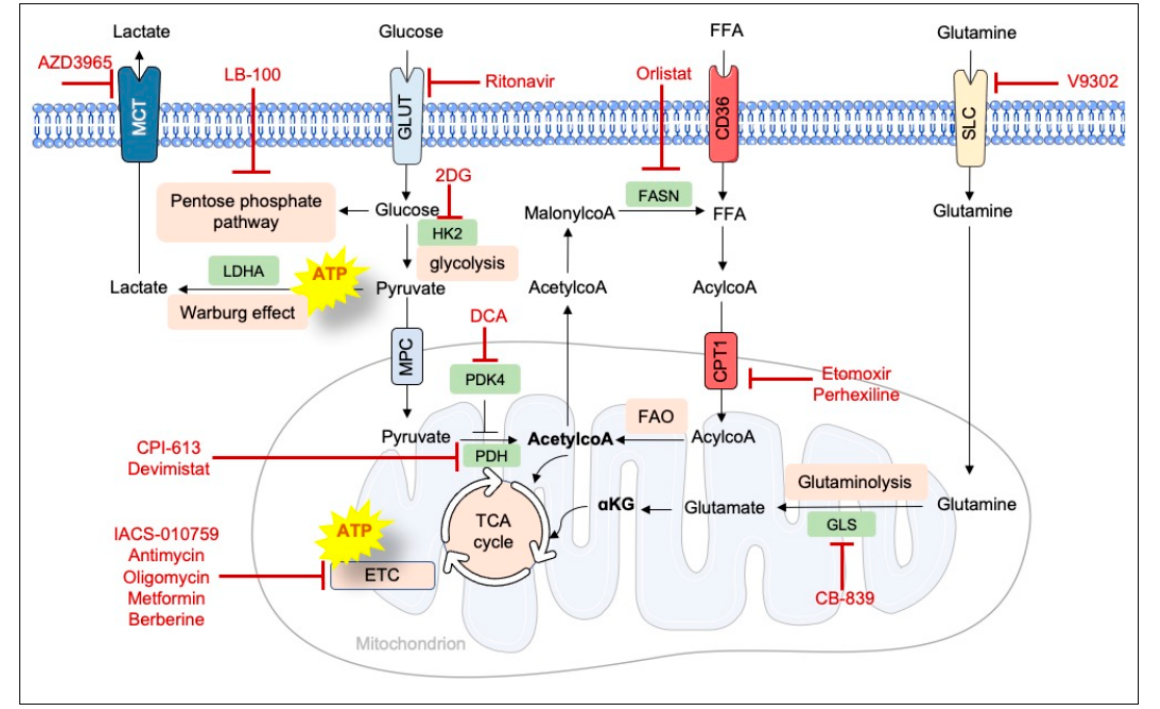
Figure 3. The cell’s main metabolic pathways and the corresponding inhibitors. Glucose, free fatty acids (FFAs) and glutamine enter cells via glucose transporters (GLUT), CD36, and solute carrier (SLC) transporters respectively. Once inside the cells, these substrates are catabolized by various metabolic reactions in the cytosol and the mitochondria in the tricarboxylic acid cycle (TCA). Cofactors produced by the TCA are used by the electron transport chain (ETC) to produce ATP. Some cancer cells shift their metabolism (and specifically glycolysis) towards lactate production; ATP is generated outside the mitochondria. Lactate can then be exported from the cells via monocarboxylate transporters (MCTs). Inhibitors are shown in red, key enzymes are labeled in green, and metabolic pathways are shown in pink. α KG, α -ketoglutaric acid; FASN, fatty acid synthase; FAO, fatty acid oxidation; GLS, glutaminase; HK2, hexokinase 2; LDHA, lactate dehydrogenase A; PDH, pyruvate dehydrogenase; PDK4, pyruvate dehydrogenase kinase 4.